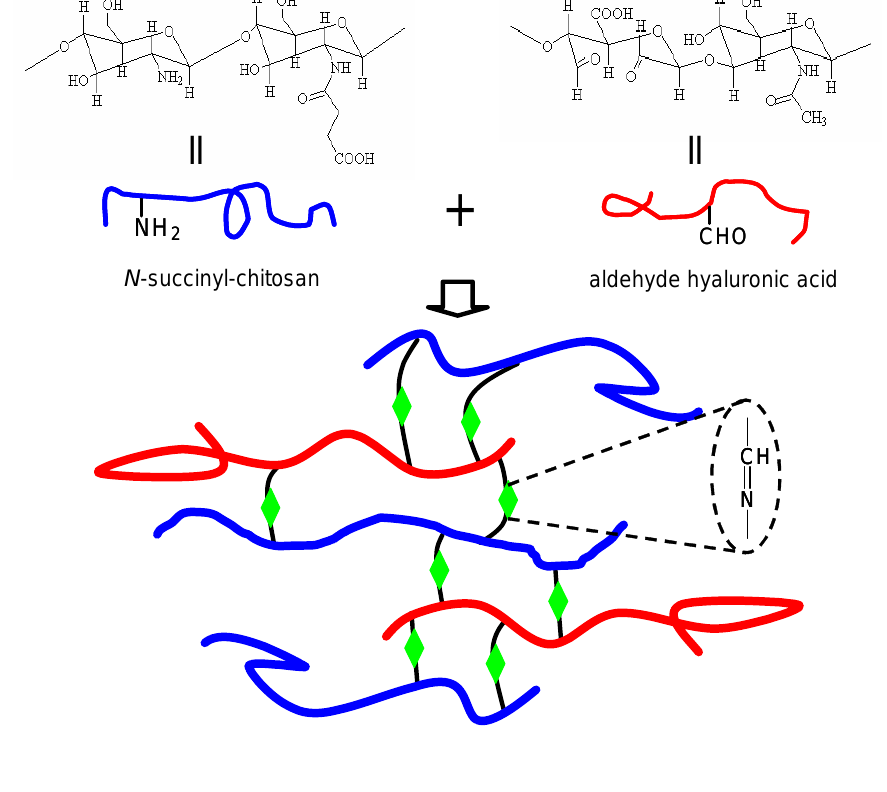
Figure 4. The scheme of N -succinyl-chitosan and aldehyde hyaluronic acid composite hydrogel via Schiff’s base cross-linking